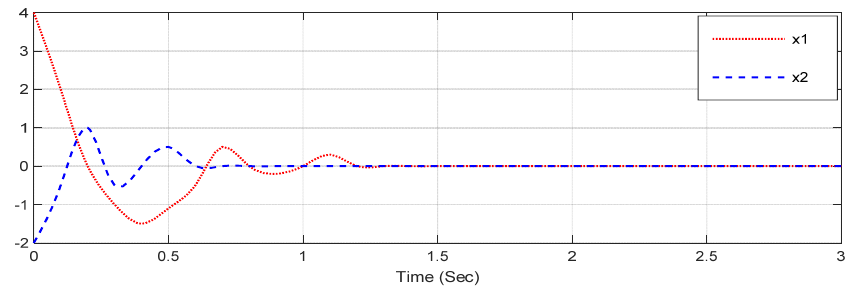
Figure 4. The states of the system (47).